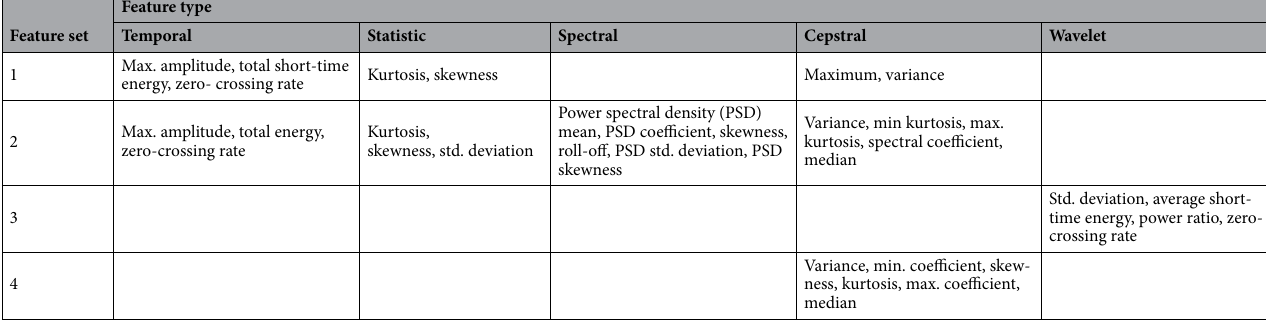
Table 7. Studied feature sets, tested on the classification and regression